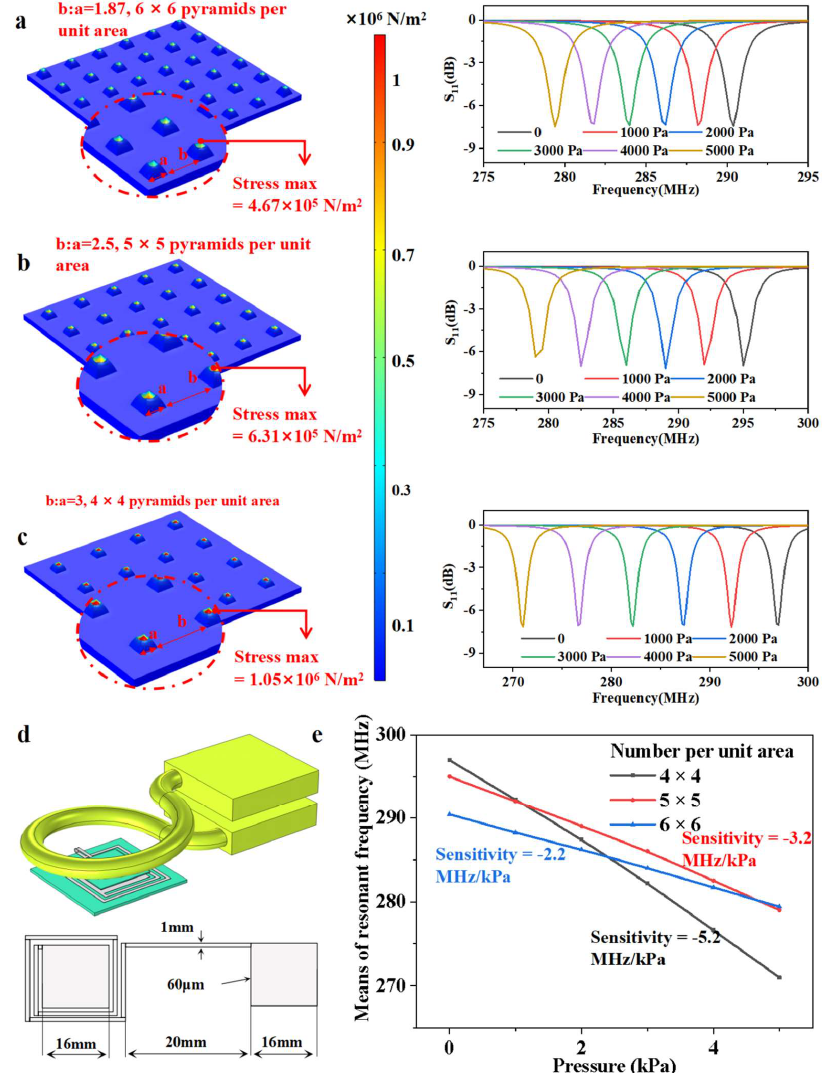
Figure 2. Optimization of the pyramid array structure using finite element analysis software. Schematic diagram of the dielectric layer with various pyramid arrays, including 6 × 6 ( a ), 5 × 5 ( b ), 4 × 4 ( c ). ( a ) Stress distribution and S11 curves of the sensor with a 6 × 6 pyramid array versus